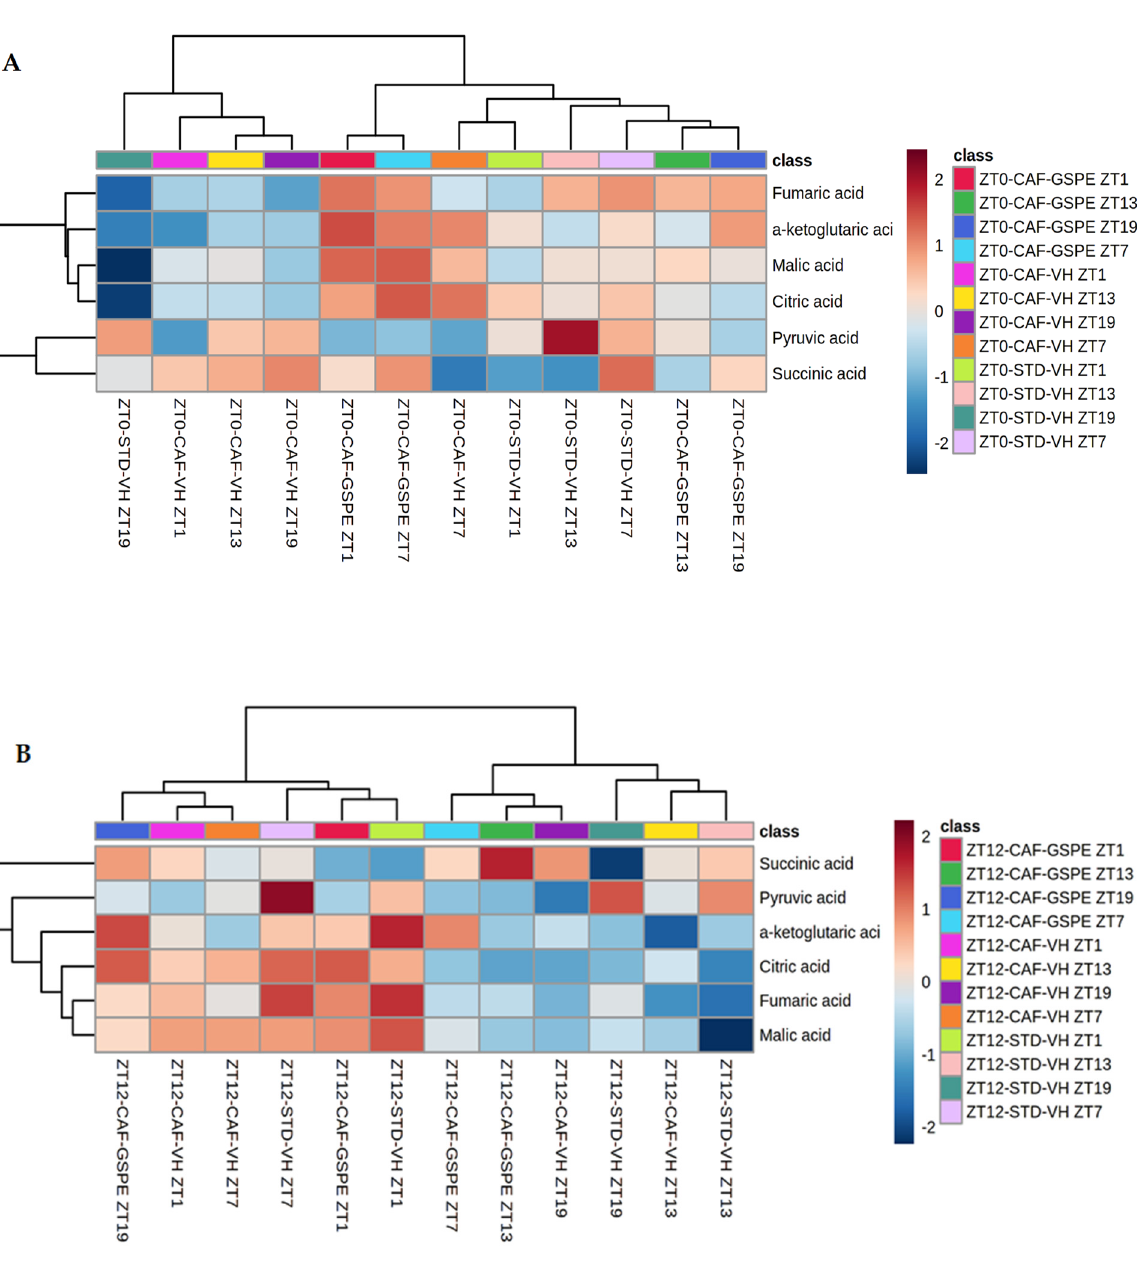
Figure 8. Heatmaps of TCA cycle metabolites in the liver. Rats were fed an STD or CAF diet and received a daily dosage of vehicle or GSPE in the morning (ZT0) ( A ) or at night (ZT12) ( B ). After 9 weeks, the rats were sacrificed at 9 a.m. (ZT1), 3 p.m. (ZT7), 9 p.m. (ZT13) or 3 a.m. (ZT19).